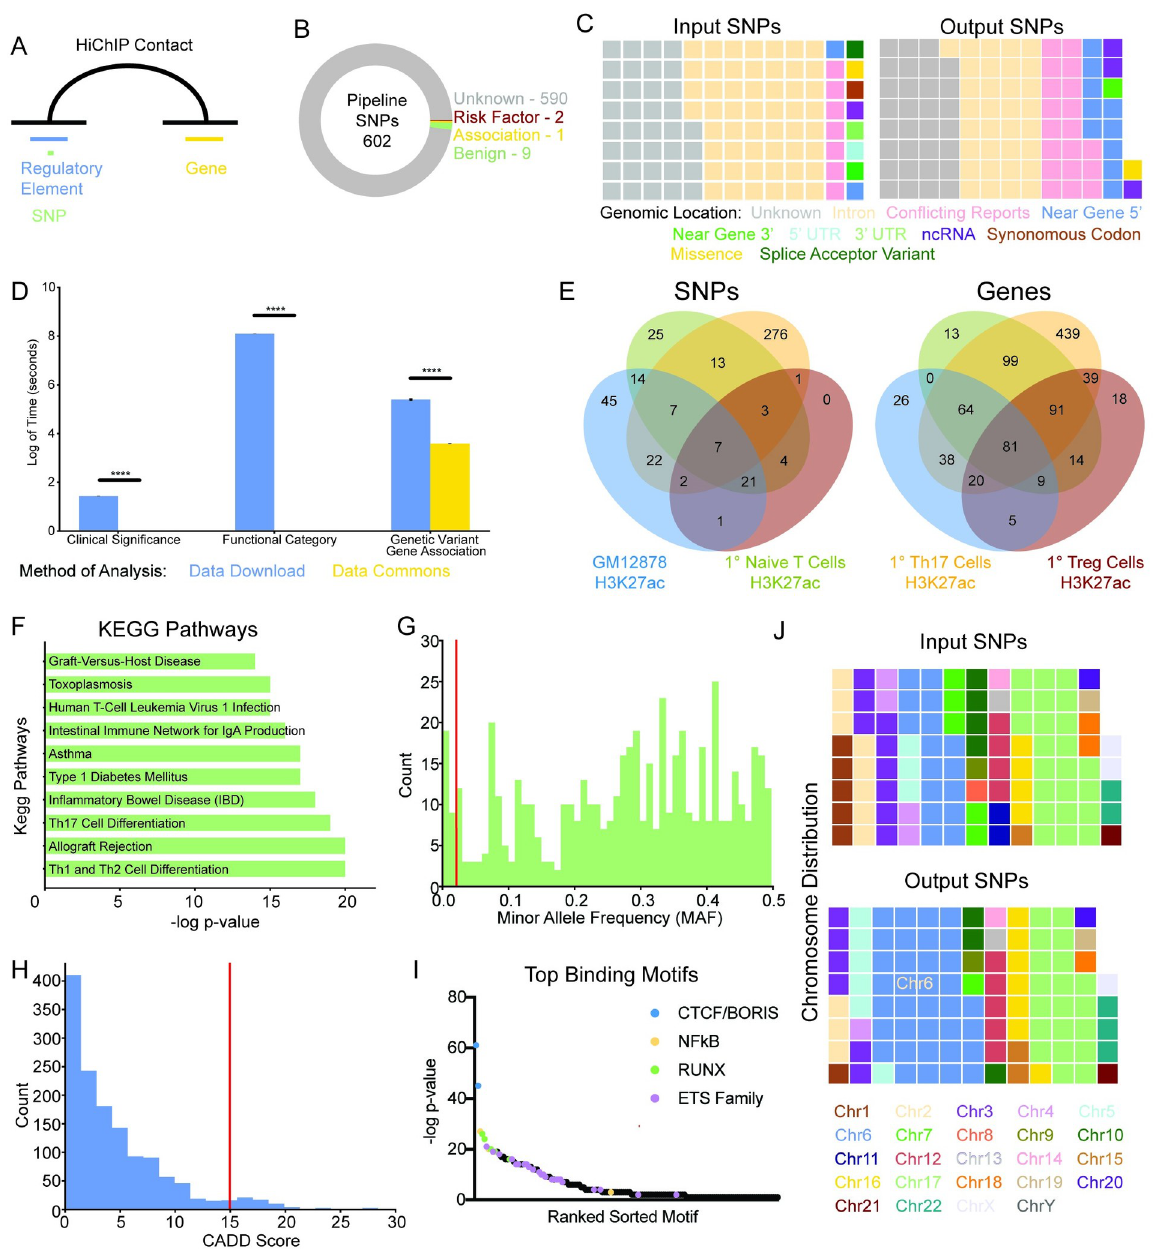
Fig 3. Pipeline prioritizes common non-coding genetic variants that are cell type specific. A: Overview of the pipeline that identifies genetic variants in regulatory elements of interest distally connected to genes via the three-dimensional chromatin conformation. B: Clinical significance of pipeline output genetic variants. C : Functional category of input and output genetic variants. D: The amount of time to run clinical significance, functional category, and significant gene association analyses using local data scientist approach involving data download (blue) or Data Commons (gold). ���� p < 0.0001. E: Venn diagram of the overlap in genetic variants (left panel) and genes (right panel) identified by the pipeline using H3K27ac HiChIP and ATAC-seq datasets from GM12878 cells (green) and primary Na ï ve T (green), Th17 (gold), and Treg (burgundy) cells as input. F: KEGG pathways associated with the target genes of pipeline genetic variants. G: Histogram of the minor allele frequency of the pipeline genetic variants. Red line at 0.02 indicates common cutoff for uncommon genetic variants. H: Histogram of pipeline genetic variants CADD score with red line at a score of 15 indicating a common cutoff for deleterious variants. I: Scatter plot of the top binding motifs of pipeline identified regulatory elements. J: The chromosomal location of input and output genetic variants. Input SNPs refers to the original candidate list of 12,974 genetic variants that were reported significantly associated with T1D in the GWAS catalog or are in linkage disequilibrium. The Output SNPs refers to the 602 genetic variants that were identified as candidates by the pipeline.